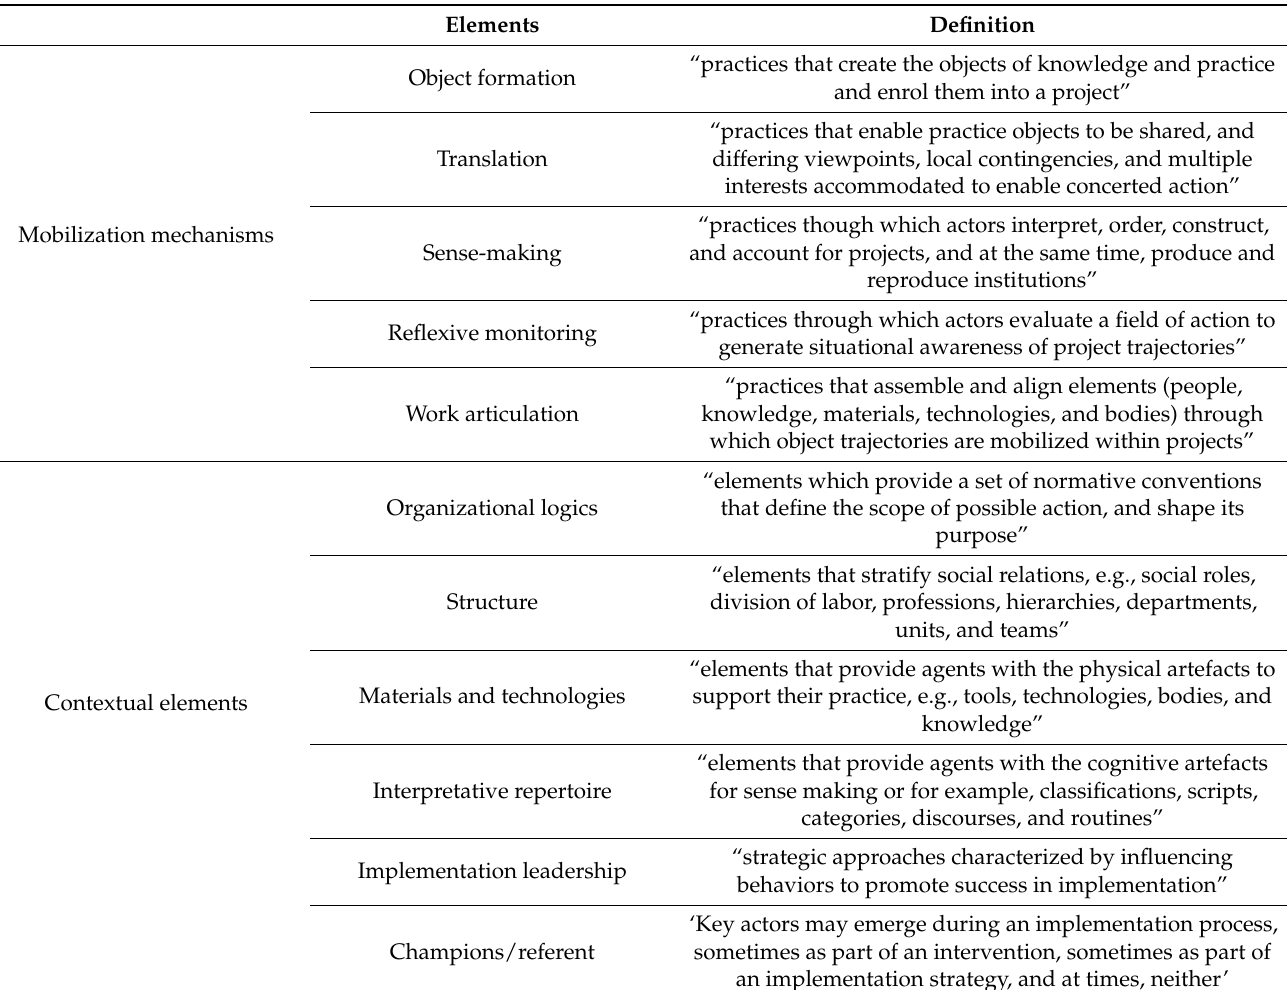
Table A1. Definitions of IFINP components based on the previous literature